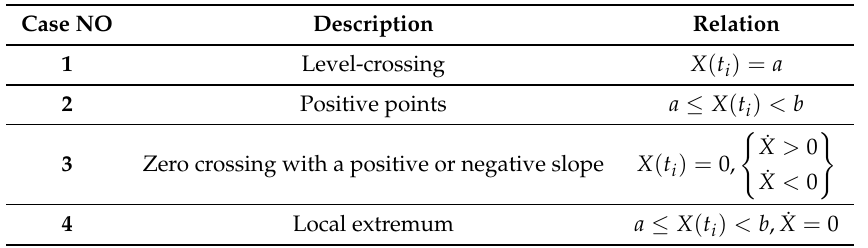
Figure 2. The basic concept of special averaging in random decrement technique (RDT). Table 1. Some recommended triggering